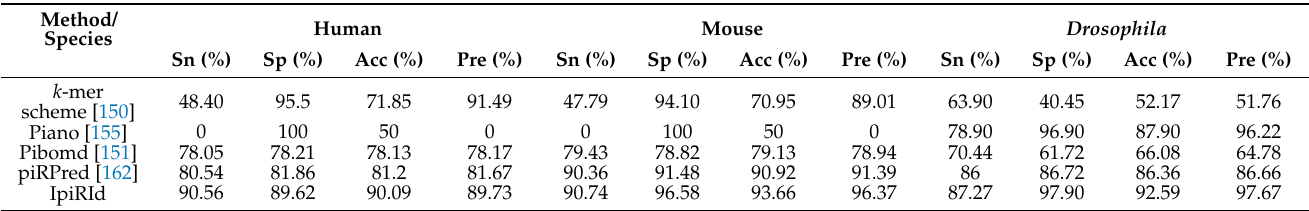
Table 6. Comparison of the performance of IpiRId with earlier